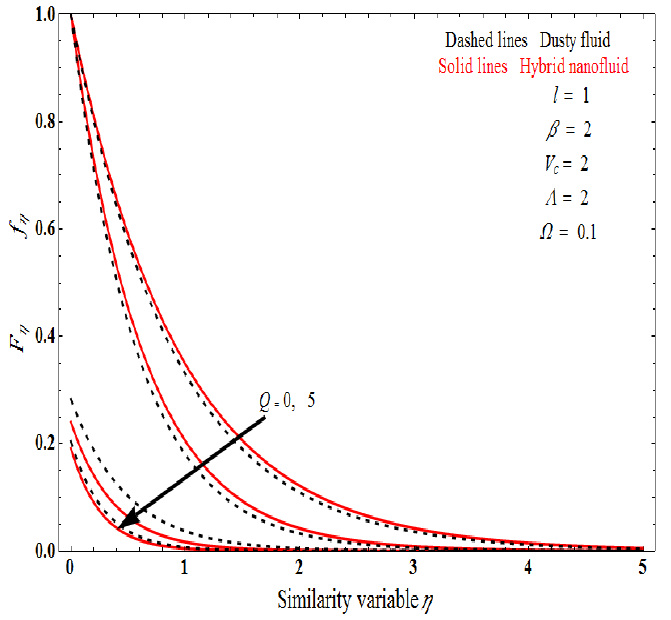
Figure 4. Influence of fluid velocity f η and particle velocity F η for the stretching surface.